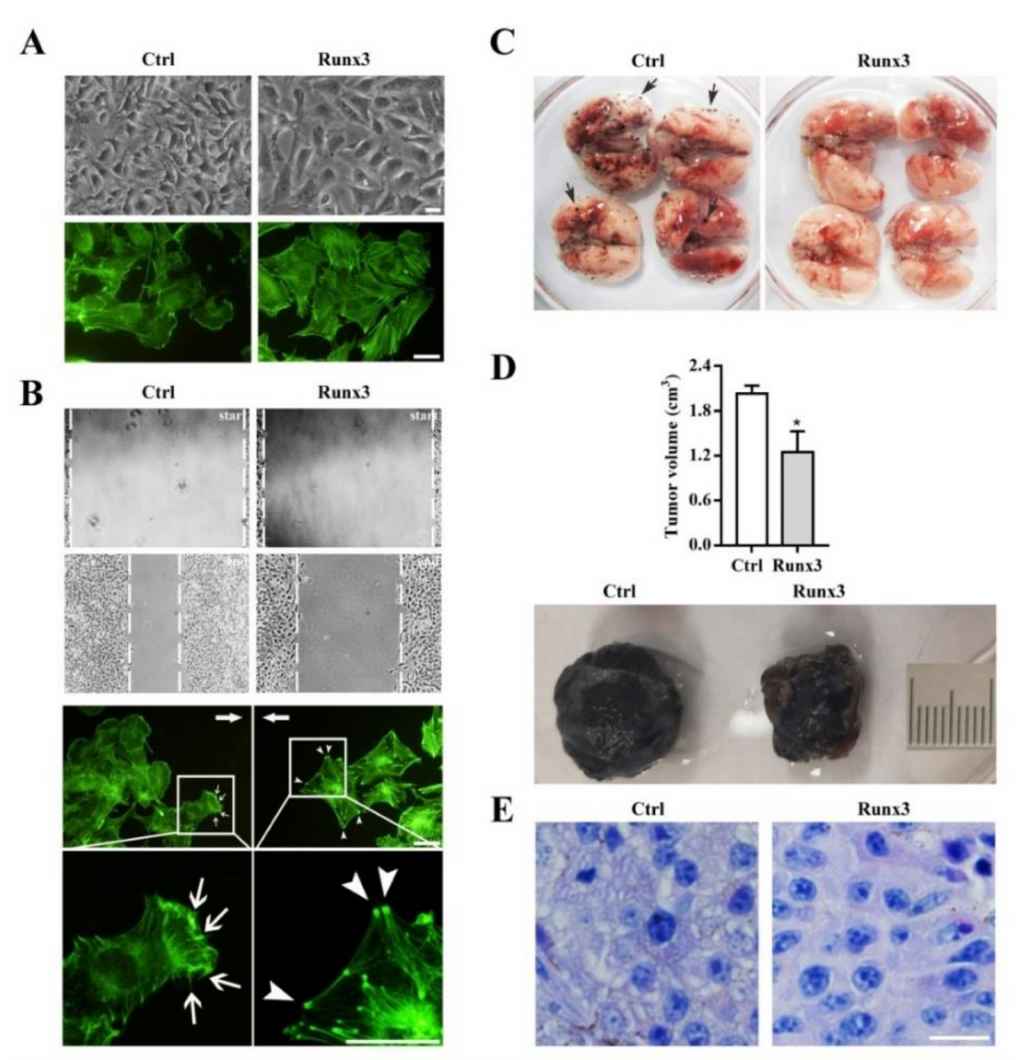
Figure 1. Runt-related transcription factor-3 (Runx3) re-expression in B16-F10 melanoma cells resulted in a cell shape change and suppressed the pulmonary metastasis of the cells. ( A ) Runx3 changed the cell shape and altered the actin cytoskeleton. The green fluorescent signals indicate actin filaments. ( B ) Runx3 delayed cell migration, and altered the dynamics of stress fiber formation in the migrating cells. Start denotes when the wound is just made, and end denotes when wound healing is terminated. The green fluorescent signals indicate actin filaments. The arrows indicate the directions of migration fronts. The arrowheads indicate the ends of stress fibers. The thin arrows indicate microspike-like structures. ( C ) Runx3 completely suppressed pulmonary metastasis. n = 4. The black dots on the surface of the lungs indicate metastasis foci. The windows-arrows representatively indicate metastasis foci. ( D ) Runx3 slightly reduced the tumor formation rate. The averaged tumor volumes are compared to each other (mean ± SEM, n = 3). * p < 0.05 is generated by the t -test. A representative image is shown. Bar: 1 cm. ( E ) Runx3 changed the cell shape in vivo. A representative section is shown. Ctrl: mock control B16-F10 cells; Runx3: B16-F10/Runx3 cells. All bars: 22 µ